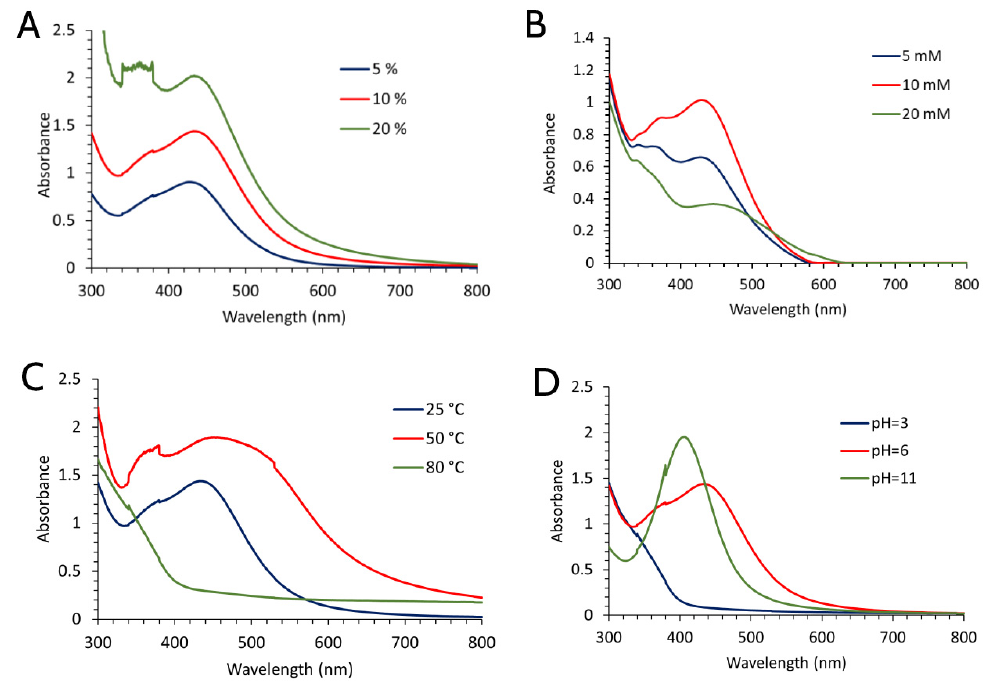
Figure 2. UV-Vis absorption spectra of AgNPs synthesized using F. ulmaria aqueous extract depend- ing on the application of different synthesis conditions (extract concentration ( A ), concentration of AgNO 3 ( B ), temperature ( C ), and pH of extract solution ( D )).